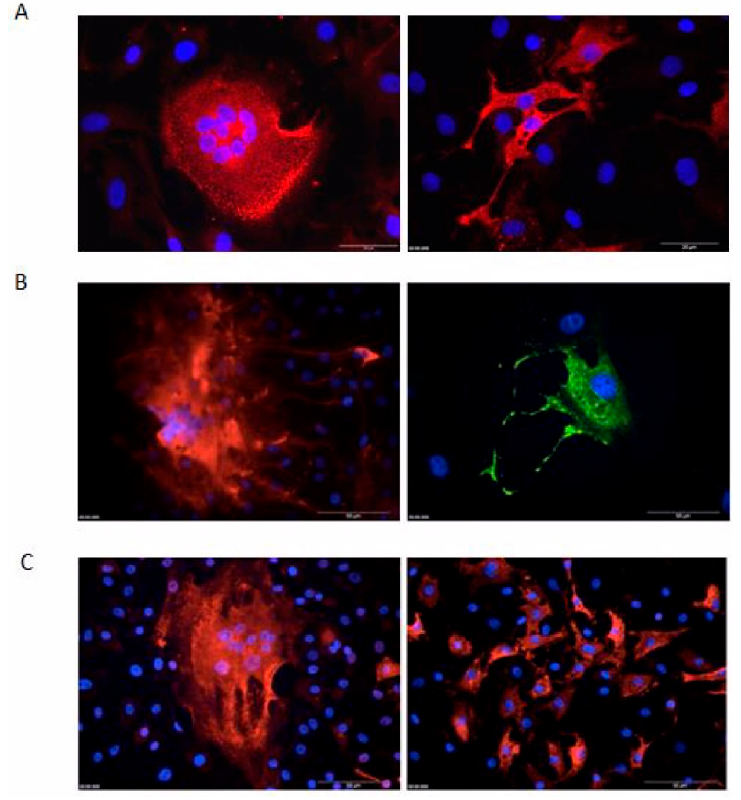
Figure 8. Syncytia, “filopodia-like” structure in BFV, and loss of syncytia formation by serially passaged HT–BFV as determined by indirect immunofluorescence (IIF) microscopy. BFV-infected KTR cells were fixed with ice-cold methanol/EGTA and incubated with a rabbit antiserum against BFV Gag MA. Alexa-594 (red) or Alexa-488 (green)-coupled anti-rabbit IgG was used as secondary antibody. Nuclei were counter-stained with Hoechst 33342 (blue). ( A ) Syncytia of original BFV Riems-infected KTR cells by IIF against Gag. The bars are 20 µ m in length. ( B ) “Filopodia-like” structures in original BFV Riems-infected KTR cells detected via IIF. The bar is 50 µ m in length. ( C ) BFV-infected KTR cells using the original BFV–Riems isolate (left hand panel) and serially passaged BFV (HT–BFV from passage 30 in BHK-21 cells, right hand panel) were analyzed by IIF against Gag MA. BFV Gag MA (red) and nuclear Hoechst 33342 (blue) staining allowed clear detection of loss of syncytia formation upon serial passaging. The bar is 50 µ m in length.